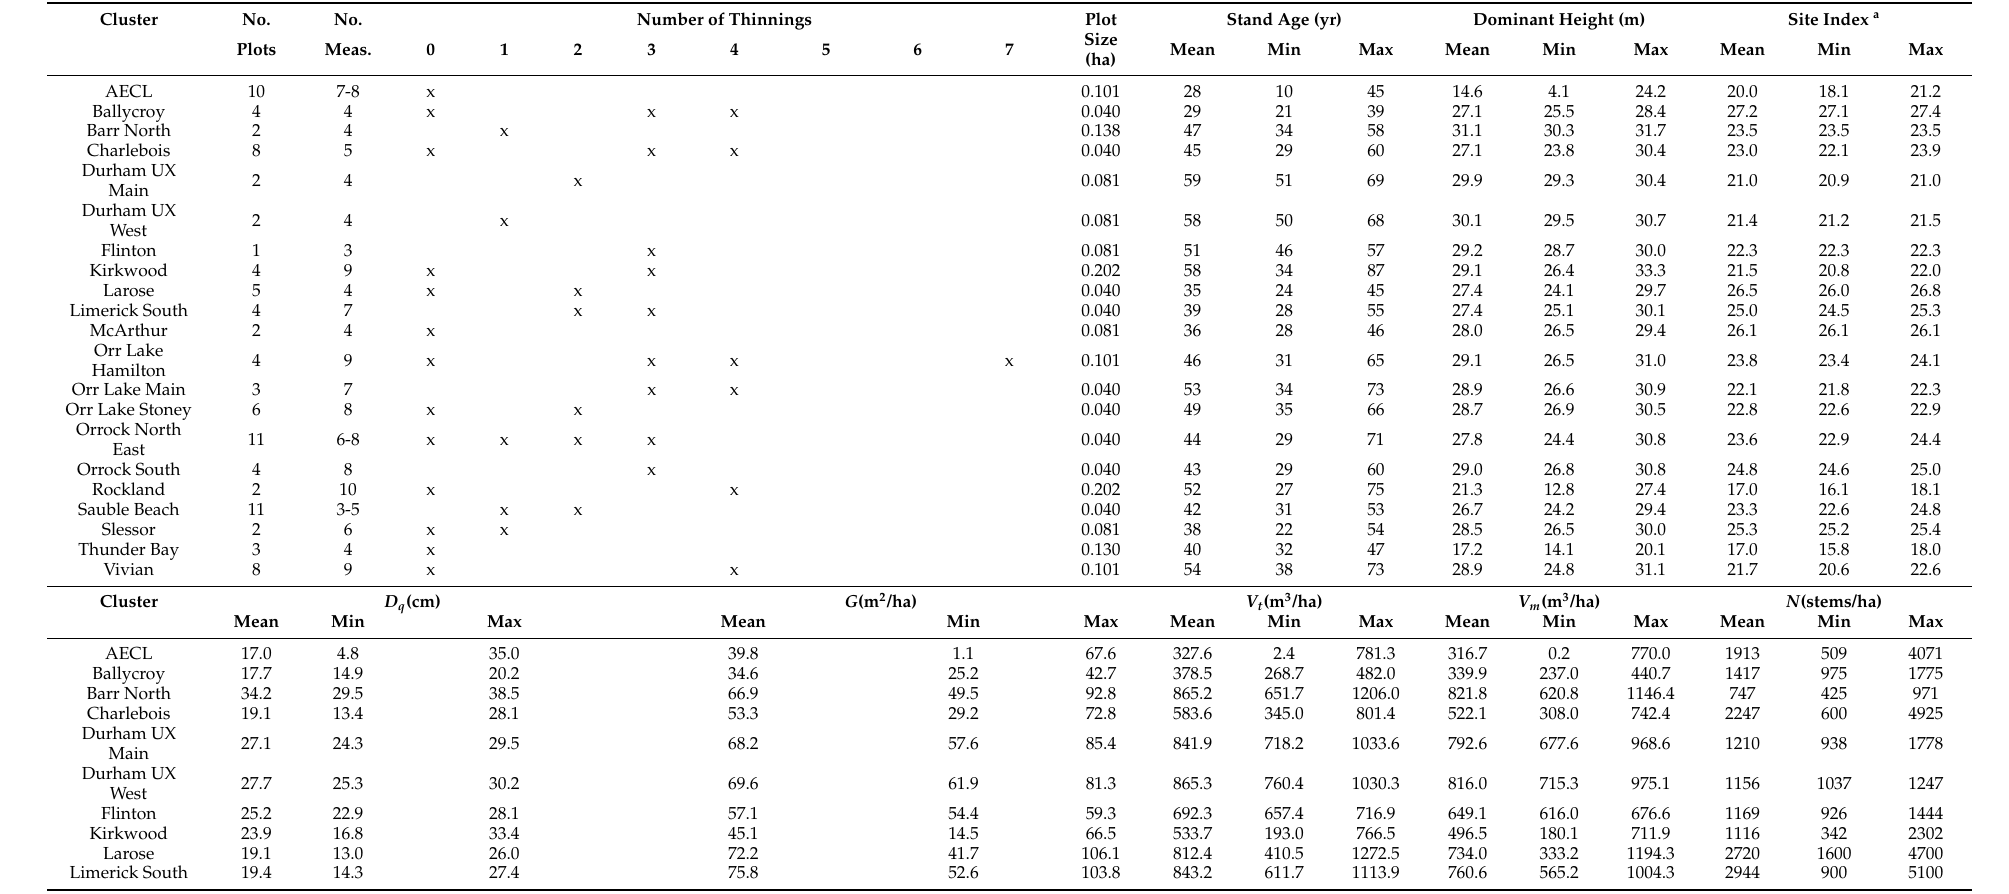
Table A1. Mensurational summary of the calibration data set: plot, treatment, site quality and stand attributes by sample